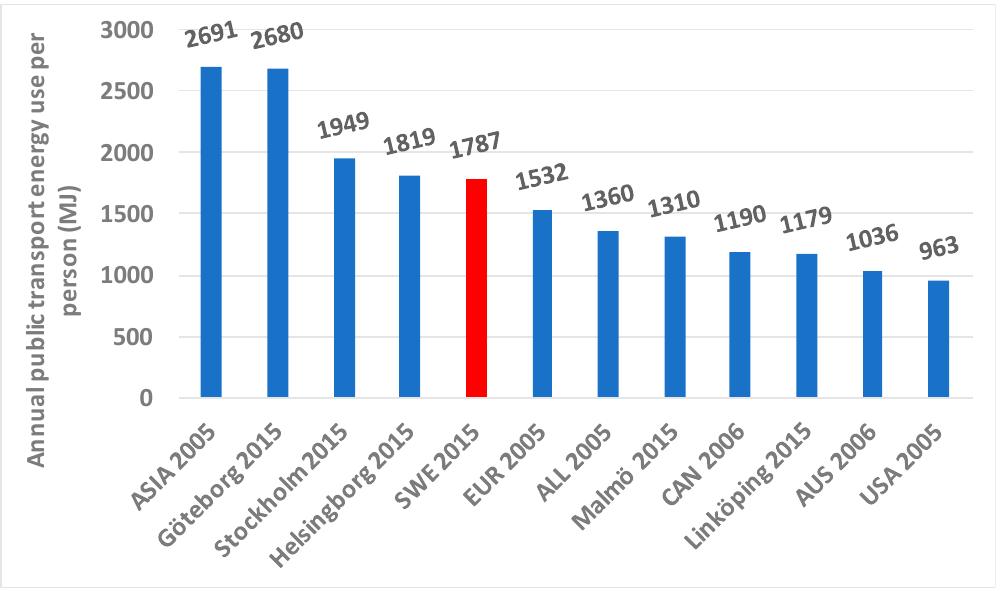
Figure 17. Annual public transport energy use per person in five Swedish cities (2015) compared to a sample of global cities (2005–2006).